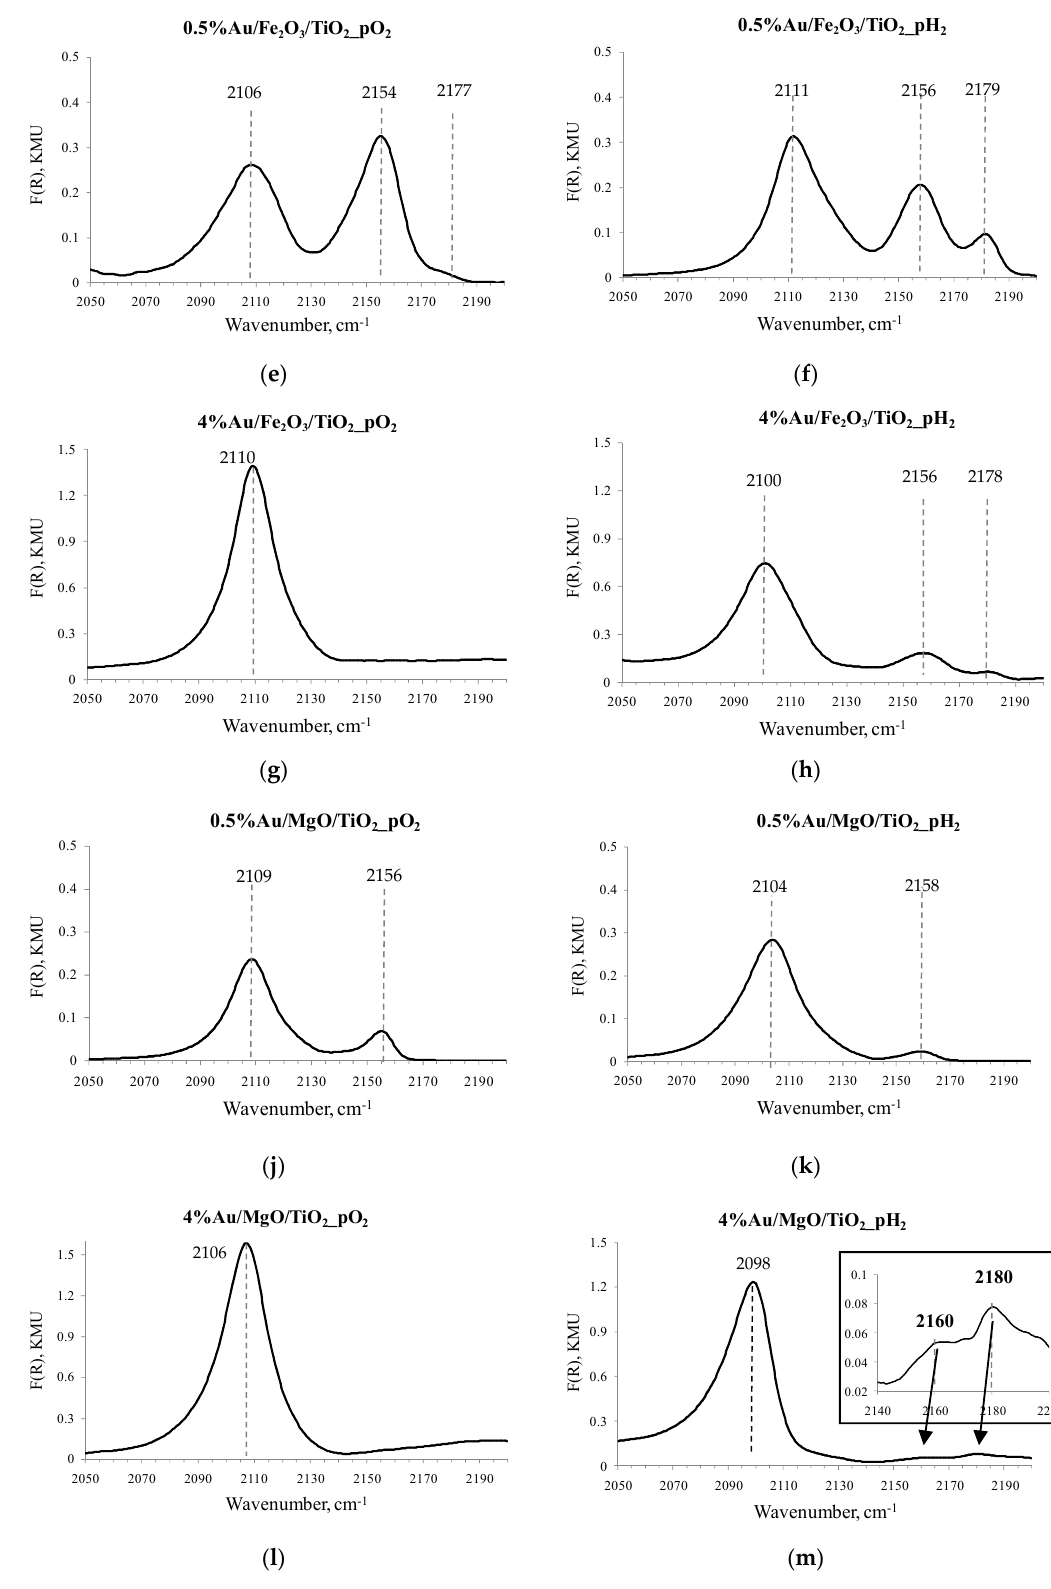
Figure 6. DRIFT spectra of CO adsorbed on catalysts pretreated at 300 °C for 1 h under a H 2 or O 2 atmosphere.